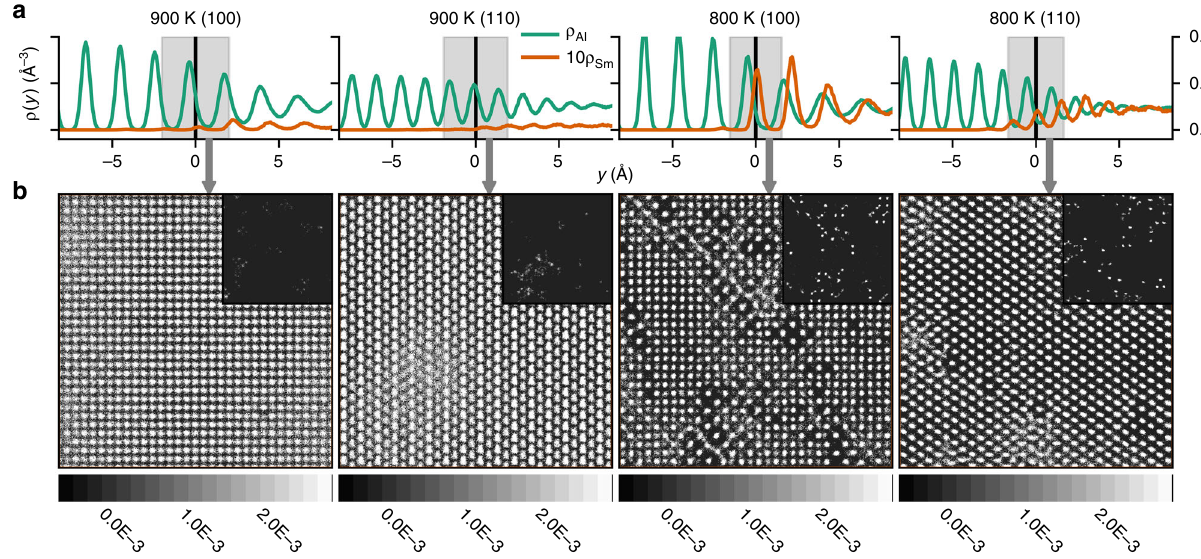
Fig. 5 Ordering near the solid – liquid interfaces. a Time-averaged atomic density pro fi les calculated from layers parallel to the solid – liquid interface for the highest (900 K) and lowest (800 K) temperatures studied. The solid – liquid interface has been set at y ¼ 0. The green curve shows the solvent (Al) atomic density while the orange curve shows the average density obtained from Sm only (the Sm density pro fi le is multiplied by 10 so as to plot on the same scale). b The total (Al + Sm) in-plane average atomic density. The averages are performed in y direction over the regions identi fi ed by the shaded grey boxes in a (extending (cid:3) 3 (cid:6) A in length perpendicular to the interface). The inset to each fi gure shows the average atomic density obtained from the Sm atoms alone. The in-plane ordering can illustrate a structure commensurate with the underlying solid. All the pro fi les are averaged over 500 snapshots (0.5 box in Fig. 5a centred on the interface position). The insets to